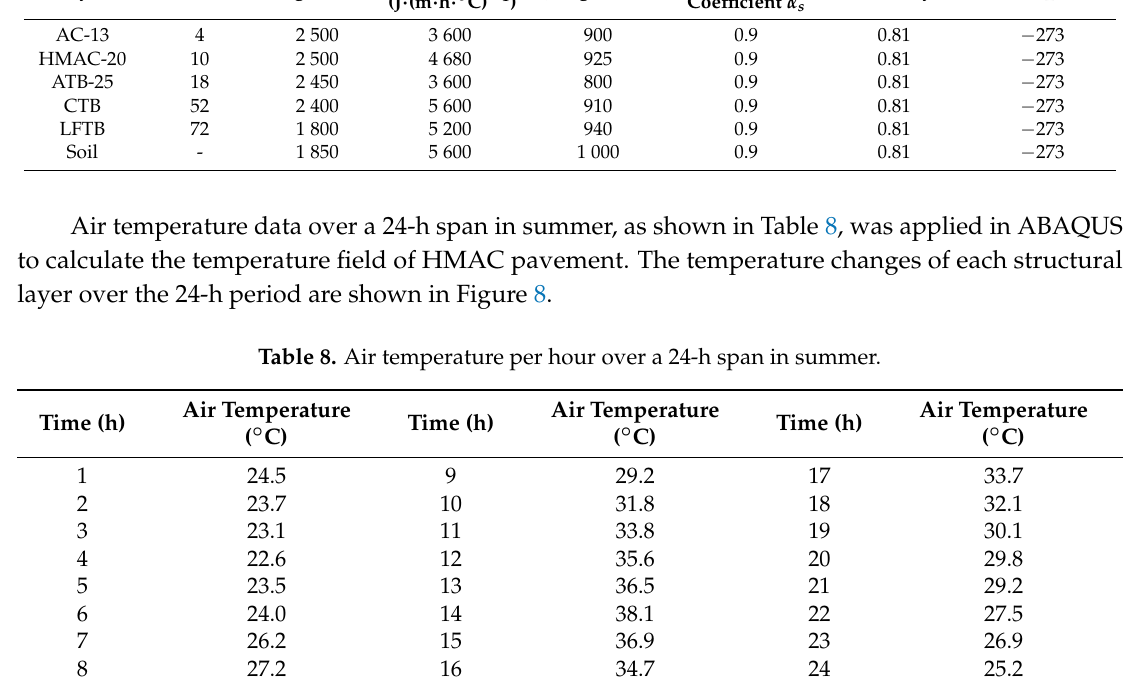
Figure 7. Comparison of vertical shear strain in the middle surface layer.